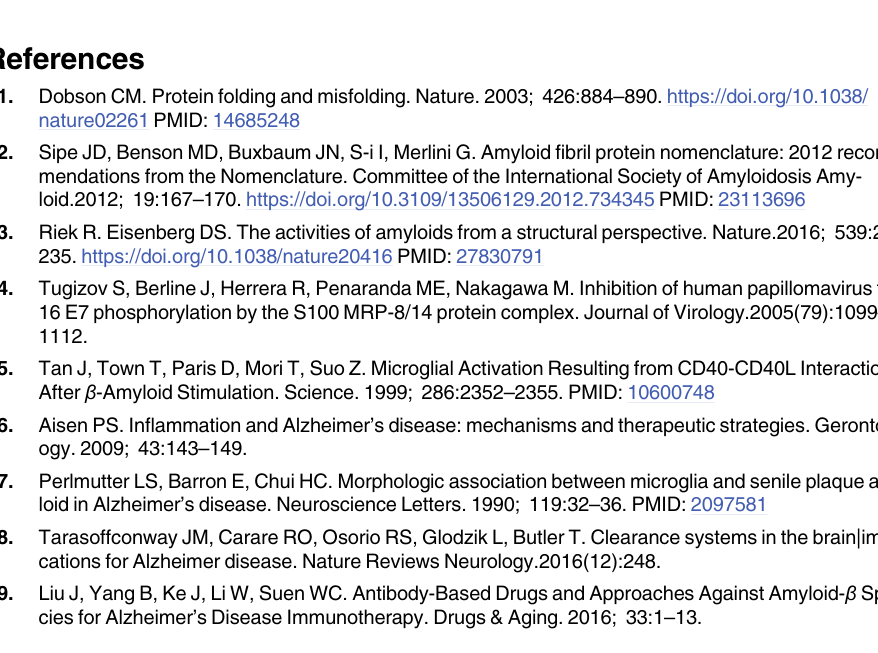
S1 Fig. Far UV CD spectra of 10 and 20 mg/ml HEWL with DMSO and OA in 20 mM gly- cine buffer under continuous shaking at 800 rpm, pH 2.3 and 57˚C. The spectra for differ- ent samples are drawn with solid lines to indicate the trend. (a, b) Changes of 10 and 20 mg/ml HEWL CD spectra with time, respectively; (c, d) CD spectra of 10 and 20 mg/ml HEWL respectively, with DMSO and OA after continuous shaking for 3 h; (e, CD spectra of 10 and 20 mg/ml HEWL respectively, with DMSO and OA after continuous shaking for 72 h. The CD spectra were recorded using 1 mm optical path length.